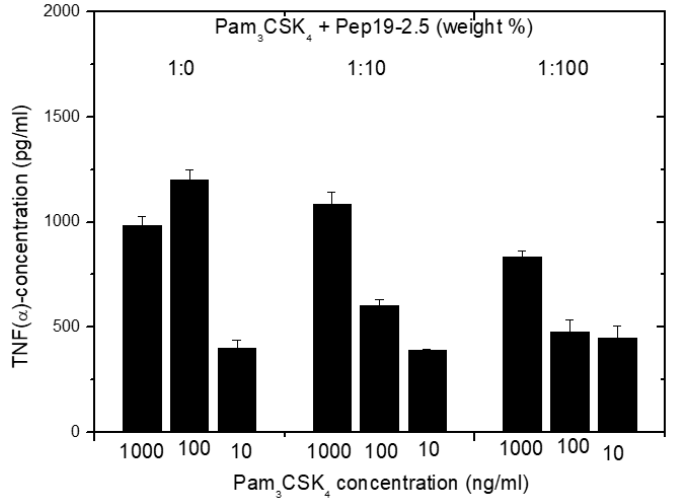
Figure 14. Cytokine induction induced by Pam 3 CSK 4 in human mononuclear cells at different concentrations of Pep19-2.5. Mean values and standard deviations due to the determination of TNF α in duplicate.